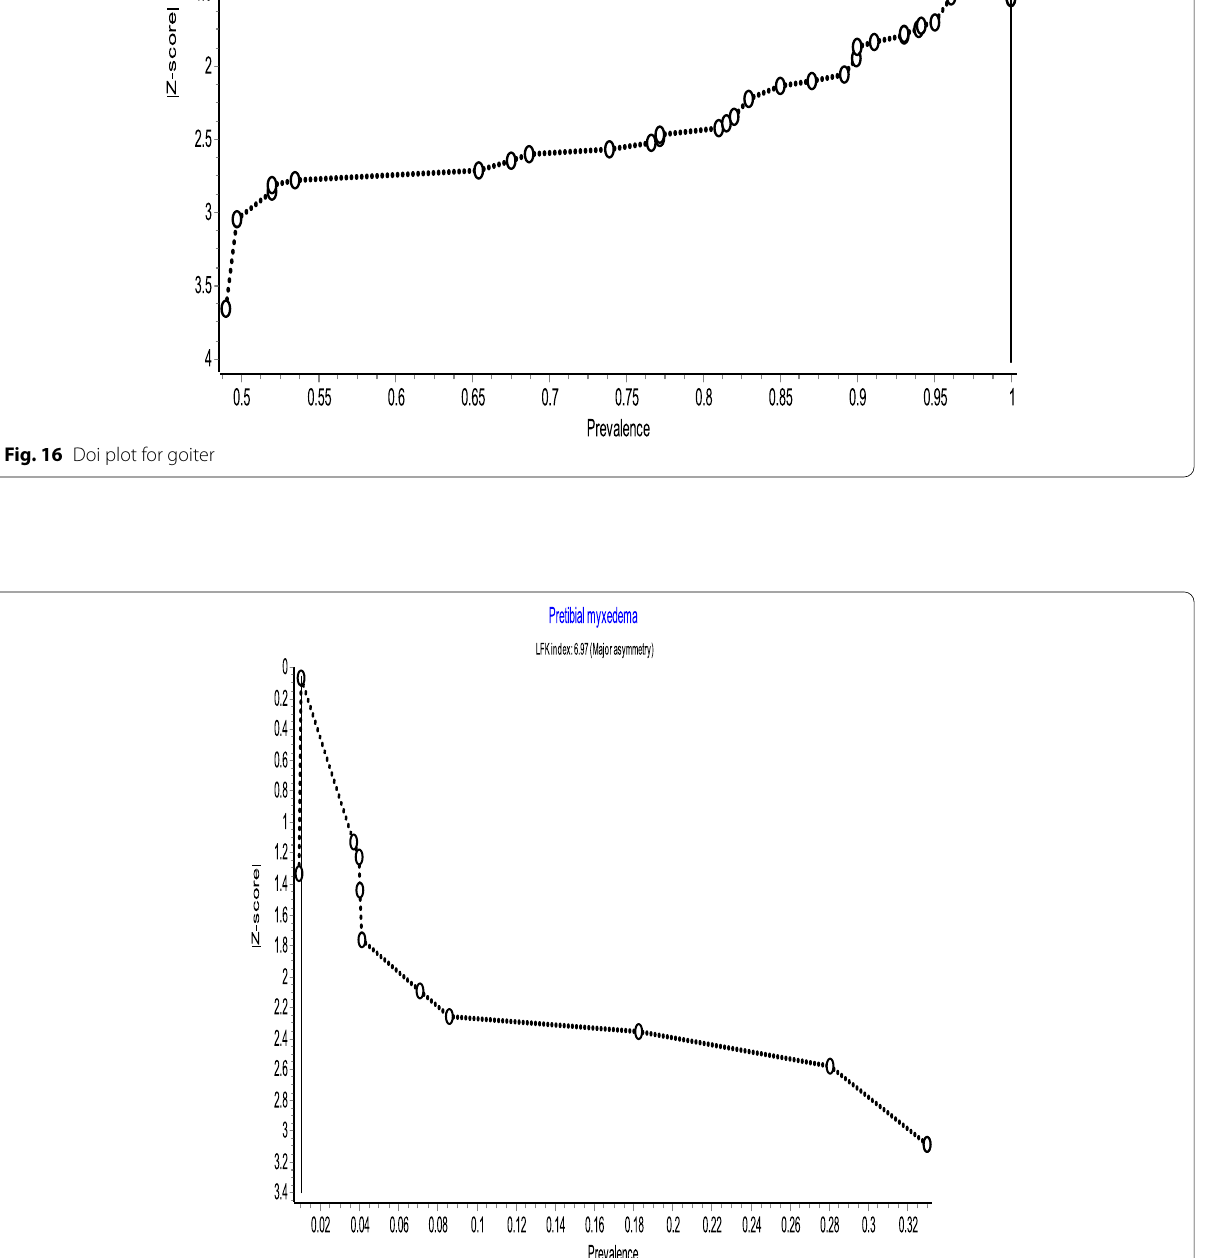
Fig 17 Doi plot for pretibial